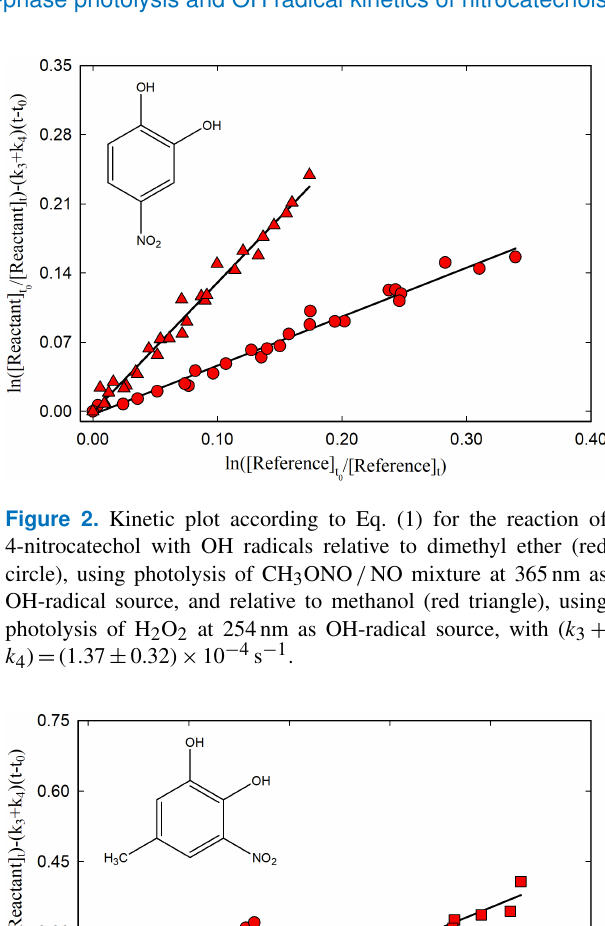
from the linear regression and an additional error from the reference compound uncertainty. As for the k 1 (average) and its uncertainty, the weighted average was used to estimate the best interval that accommodates the highest confidence of the obtained data. Based on the daytime average concen- tration of the OH radicals in the atmosphere (Prinn et al., 1995), of 1.6 × 10 6 cm − 3 , Table 1 lists also the atmospheric residence time of the studied nitrocatechols. No significant differences were observed for 4-nitrocatechol and 4-methyl- 5-nitrocatechol rate coefficient values when NO x or NO x - free conditions have been